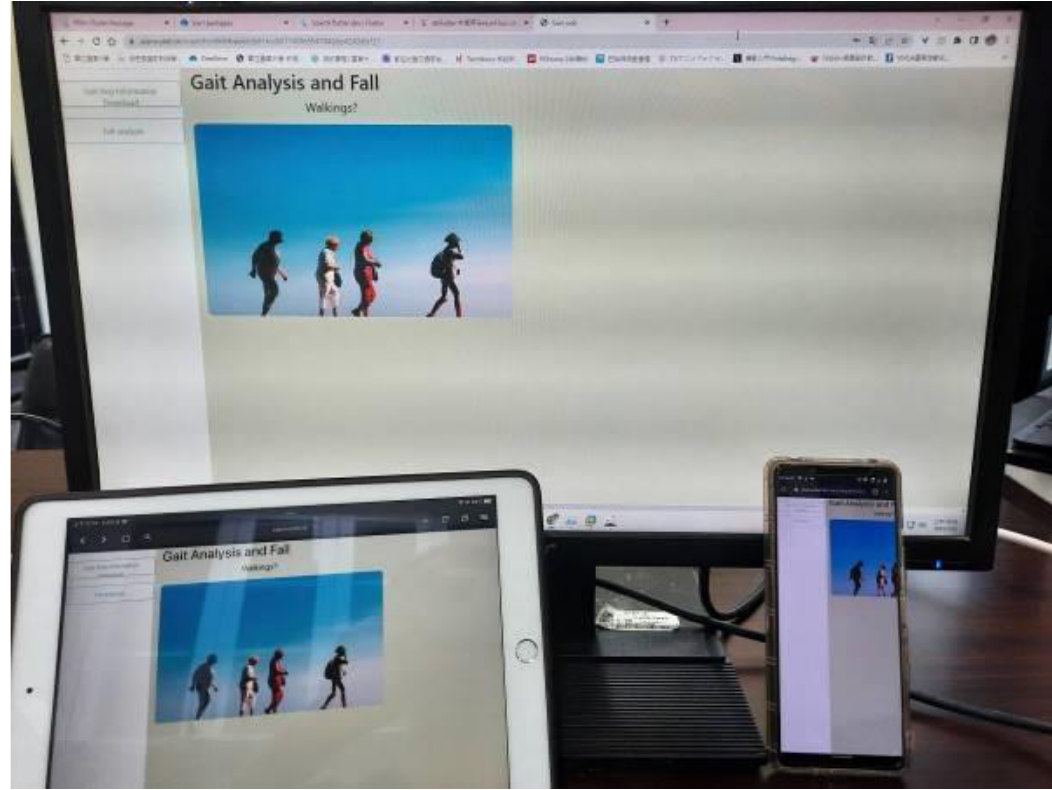
Figure 2. User interface of CPGAFDWD in different platform. In CPGAFDWD, the development board was used as Arduino board. The sensing modules, such as gyroscope and three-axis accelerometer, were used. The communication modules, such as Bluetooth and WiFi, were used. CPGAFDWD was integrated the Arduino board with the gyro- scope, three-axis accelerometer, Bluetooth, and WiFi to detect the gait analysis and fall accident. The sensed data of gait analysis and fall accident from CPGAFDWD were transmitted to APP in real time.